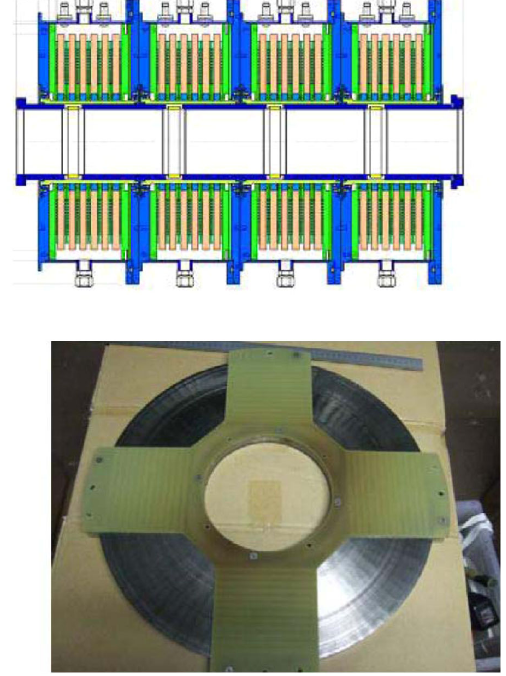
FIG. 29. Inner structure of an IC (top) and a magnetic core bobbin and G-10 spacer with oil flow channels